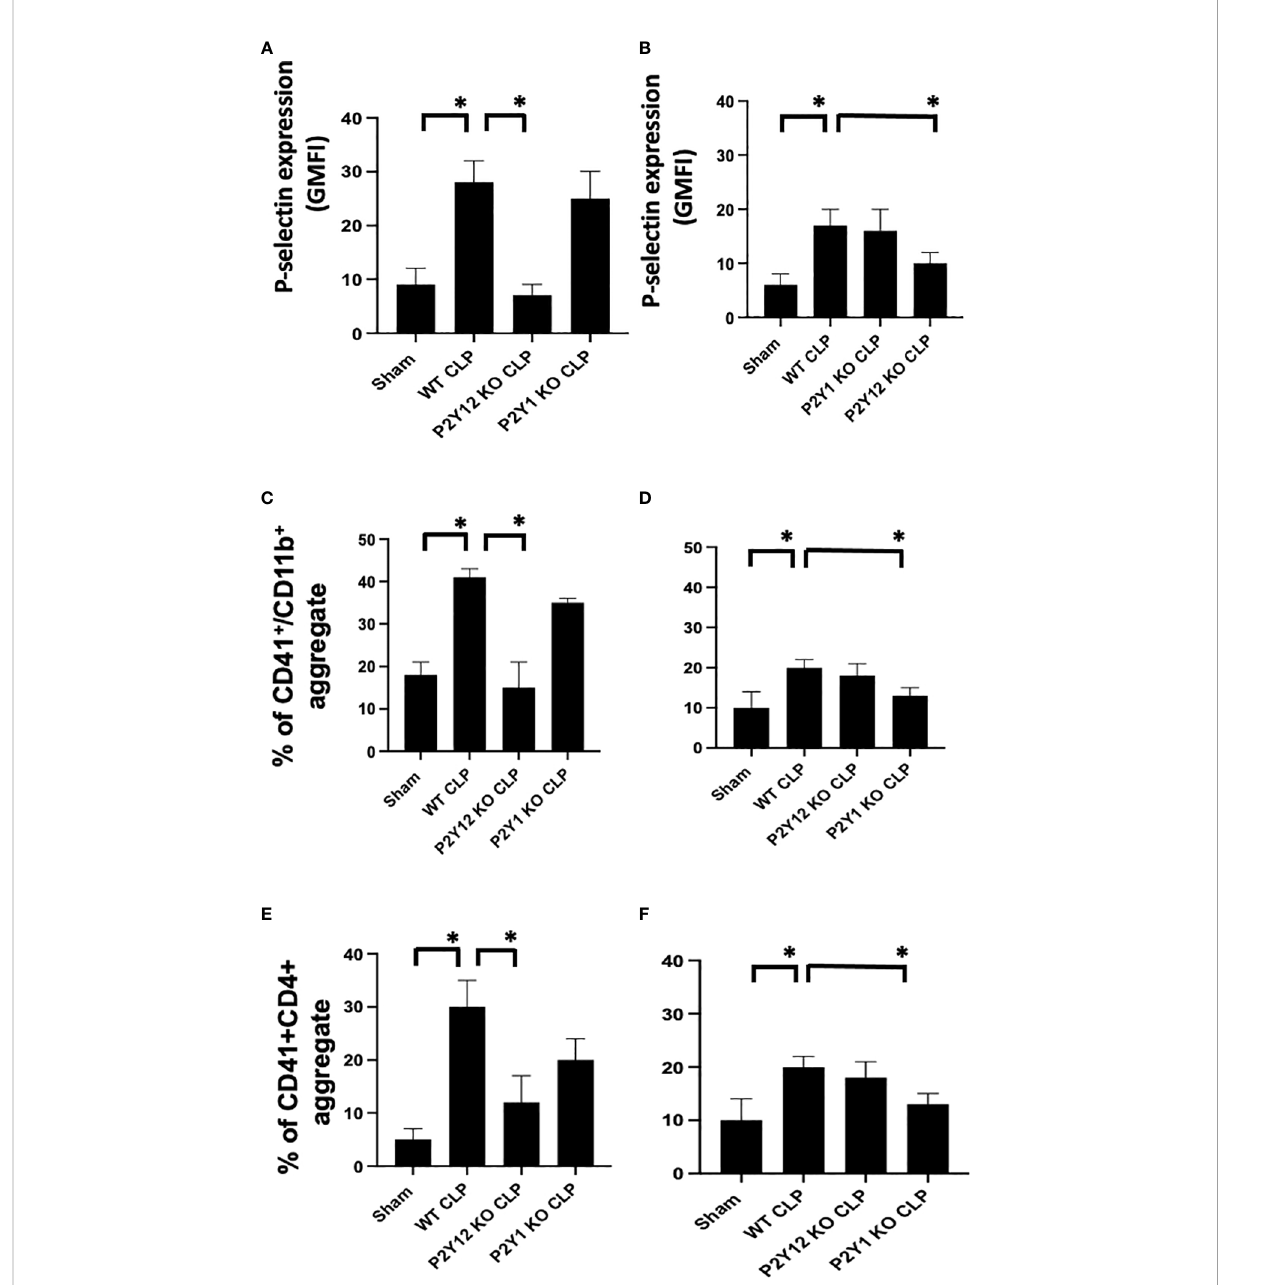
FIGURE 3 Sepsis-induced platelet activation and CD41+/CD11b or CD41+/CD4+ aggregates were decreased in male septic P2Y 12 and female septic P2Y 1 KO mice. Blood samples were collected by cardiac puncture in 3.8% sodium citrate (10:1) (A, B) P-selectin expression on the platelet surface was evaluated using fl ow cytometry in whole blood. Data were collected from WT, P2Y 12 KO, and P2Y 1 mice of male (A) and female (B) mice. Both Sham and CLP were analyzed. (n=6) (*P<0.05) Values are expressed as Geometric Mean of fl uorescence intensity (GMFI), mean ± S.E.M No differences between WT, P2Y 12 KO, and P2Y 1 KO sham were noted in both male and female mice. (C, D) Peripheral blood collected from WT, P2Y 12 KO, and P2Y 1 mice of male (C) and female (D) mice were incubated with antibodies against CD41 (platelet marker) and CD11B (leukocyte marker). Activated leukocytes were gated based on CD11b expression, and cell shape and data were analyzed as a percentage of aggregates expressing both CD41 and CD11b. Values are expressed as the percentage of CD41+/CD11b+ cells, mean ± SEM, n=5). No differences between WT, P2Y 12 KO, and P2Y 1 KO sham were noted in both male and female mice. (*P<0.05). (E, F) Peripheral blood collected from WT, P2Y 12 KO, and P2Y 1 mice of male (E) and female (F) mice was incubated with antibodies against CD41 (platelet marker) and CD4 (T cell marker). T cells were gated based on CD4 expression and cell shape, and data were analyzed based on the percentage of aggregates that express both CD41 and CD4 (n = 6). No differences between WT, P2Y 12 KO, and P2Y 1 KO sham were noted in both male and female mice (data not shown). (*P <